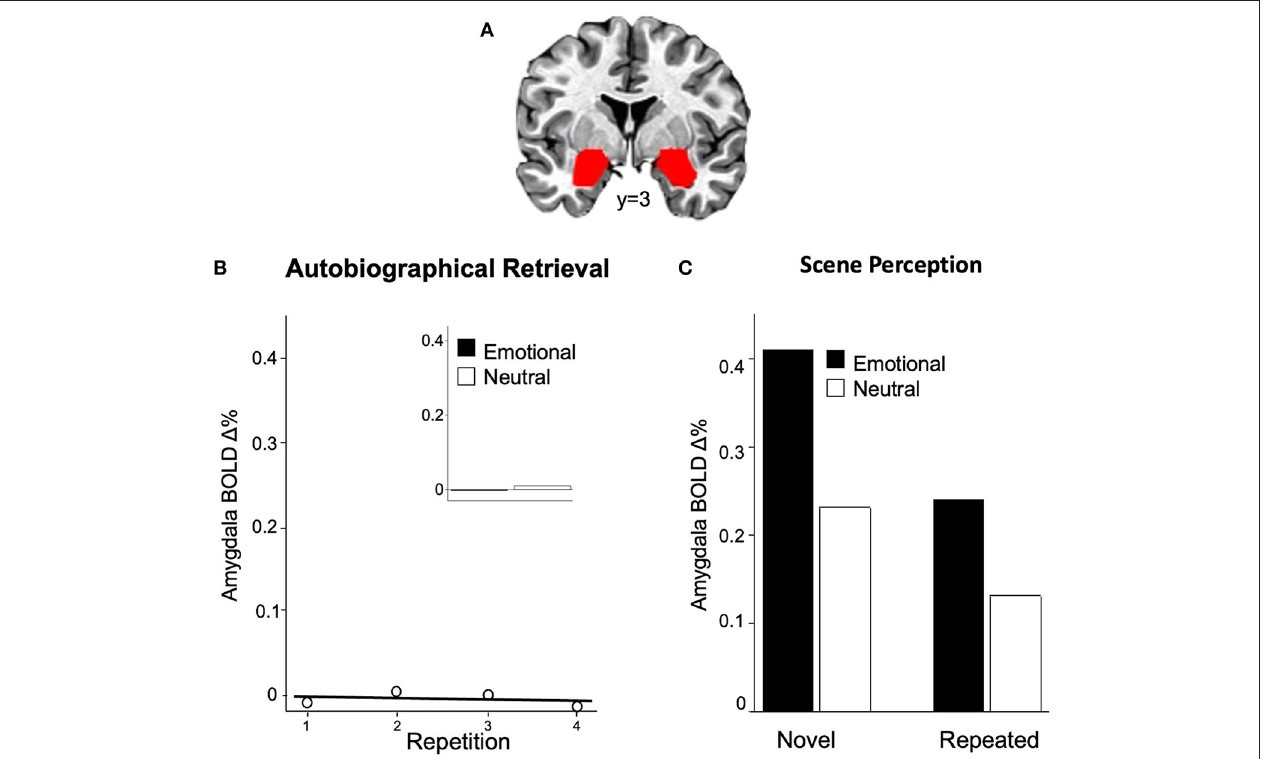
FIGURE 1 | Enhanced functional brain activity in the amygdala (A) is not found when repeatedly retrieving emotional autobiographical events (B) , with no difference between emotional and neutral content [ (B) , inset]. Amygdala activation is consistently found when [ (C) , left] encoding emotional, compared to neutral, pictures but is significantly reduced (repetition suppression) when the same scenes are repeatedly retrieved [ (C) , right].